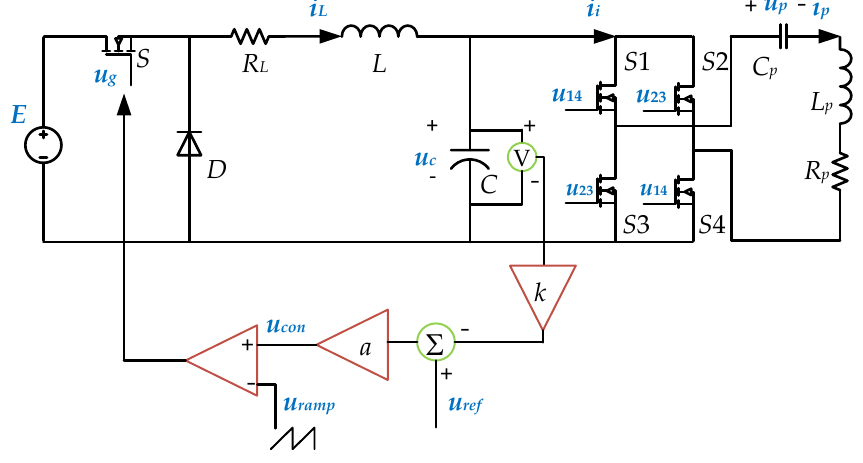
Figure 1. Diagram of a voltage-controlled Buck-inverter cascade system.